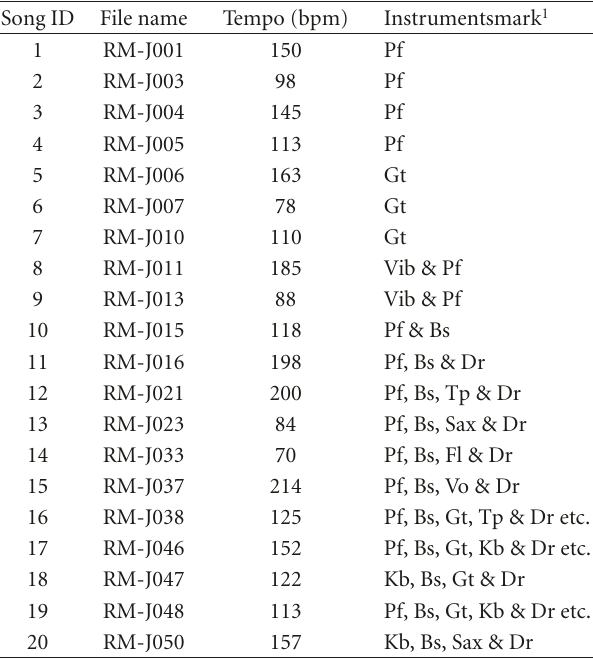
Table 2: Songs used for the experiments.